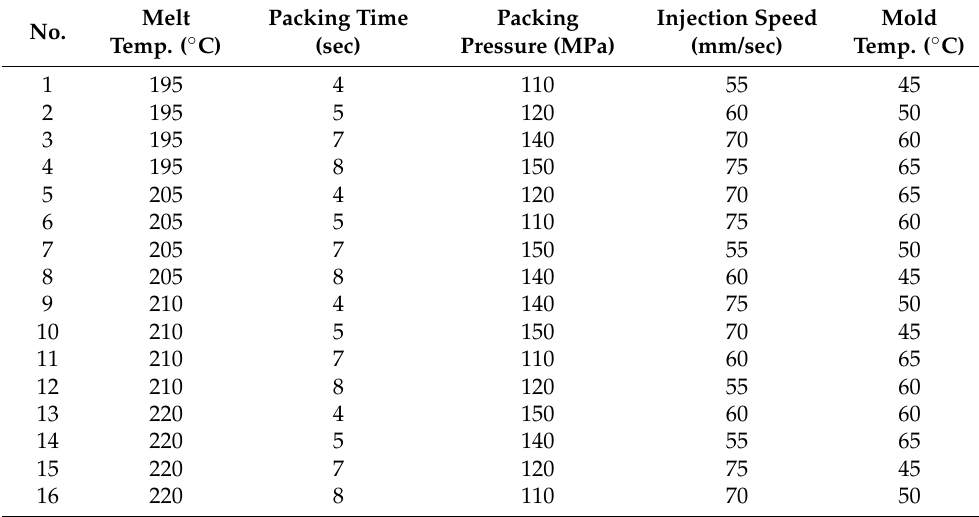
Table 2. Validation data settings (CAE-243).